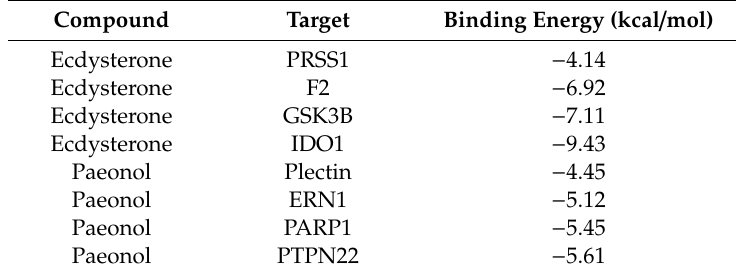
Table 2. Binding energy of Ecdysterone and Paeonol between four representative receptors. Compound Target Binding Energy (kcal / mol) Ecdysterone PRSS1 − 4.14 Ecdysterone F2 − 6.92 Ecdysterone GSK3B − 7.11 Ecdysterone IDO1 − 9.43 Paeonol Plectin − 4.45 Paeonol ERN1 − 5.12 Paeonol